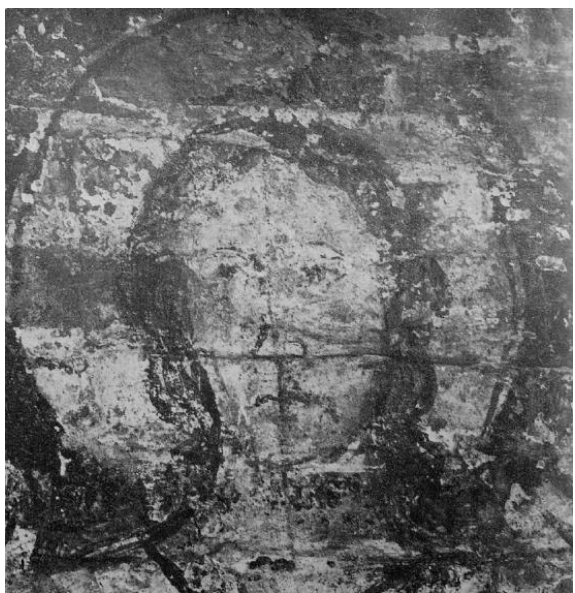
Figure 6. High-definition archival image (Comune di Pisa,